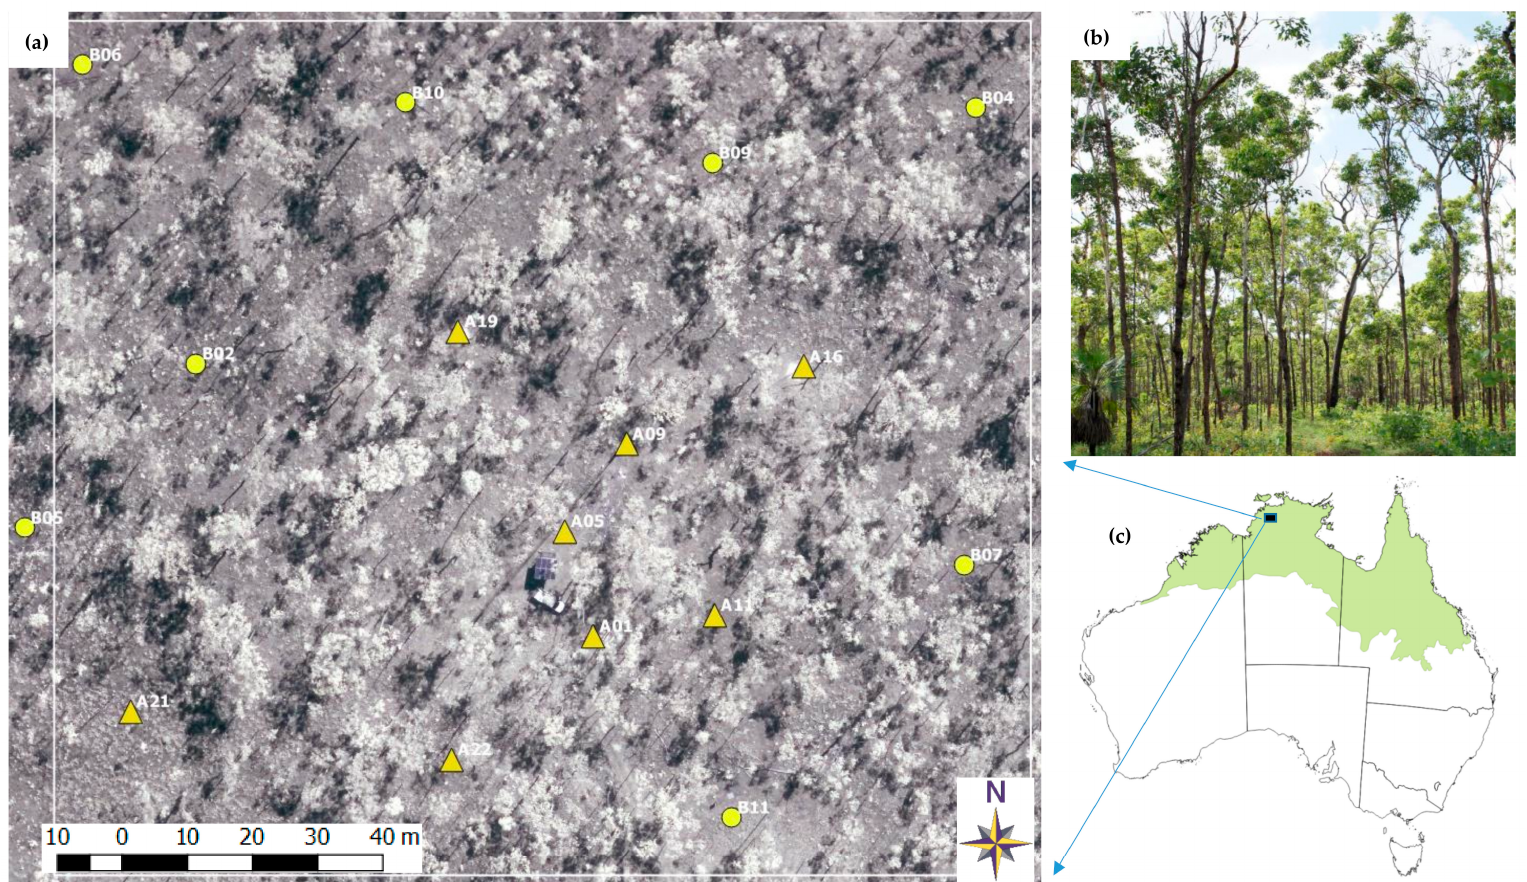
Figure 2. The 2.2 ha study area: ( a ) with ground control points (GCPs) locations ( ∆ —full GCP (XYZ), O—height GCP (Z)); ( b ) dominated by Eucalyptus spp . ; ( c ) in the north Australian tropical savanna (in green).